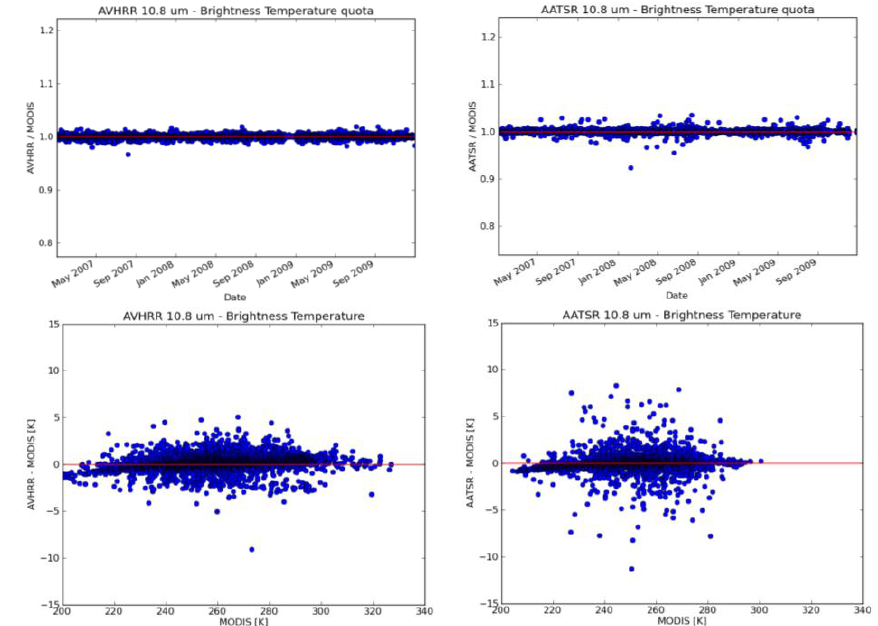
Figure 9. Inter-comparison of brightness temperatures against MODIS for the AVHRR-heritage channel at 11 µm for AVHRR ( Left ) and AATSR ( Right ). Upper panels show results expressed as brightness temperature quotas over time and lower panels show results expressed as brightness temperature differences as a function of MODIS brightness